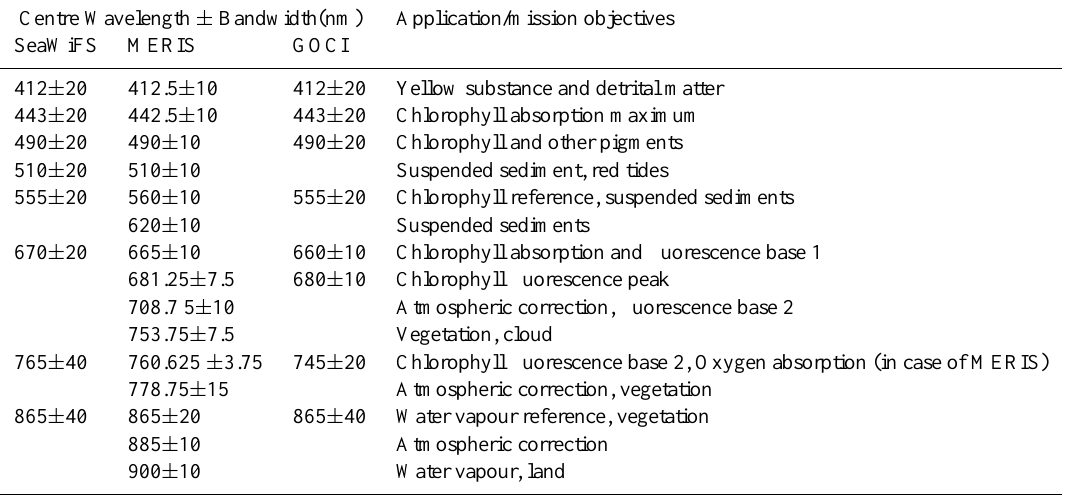
Table 3. The characteristics of SeaWiFS, MERIS and GOCI sensors.